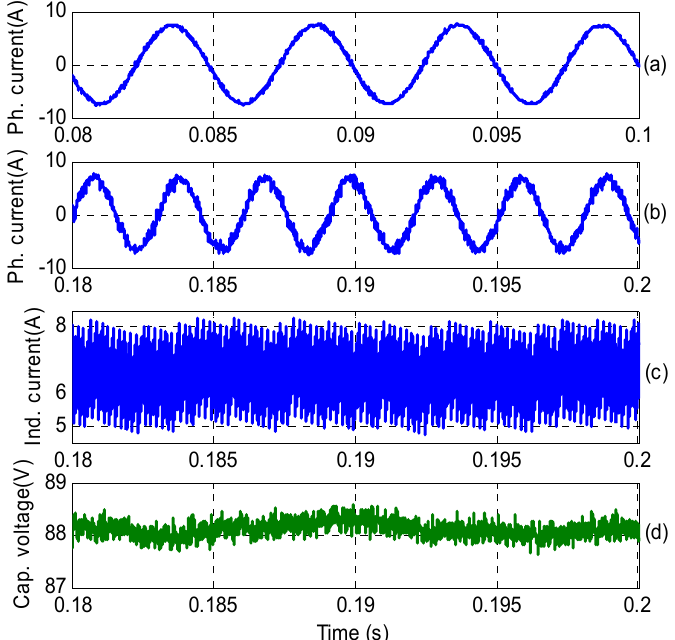
Figure 12. Steady-state performance of the unmodulated MPC at a sampling time of 20µs: ( a ) phase- current below the base speed, ( b ) phase-current above the base speed, ( c ) inductor current in boosting mode, and ( d ) capacitor voltage above the base speed.